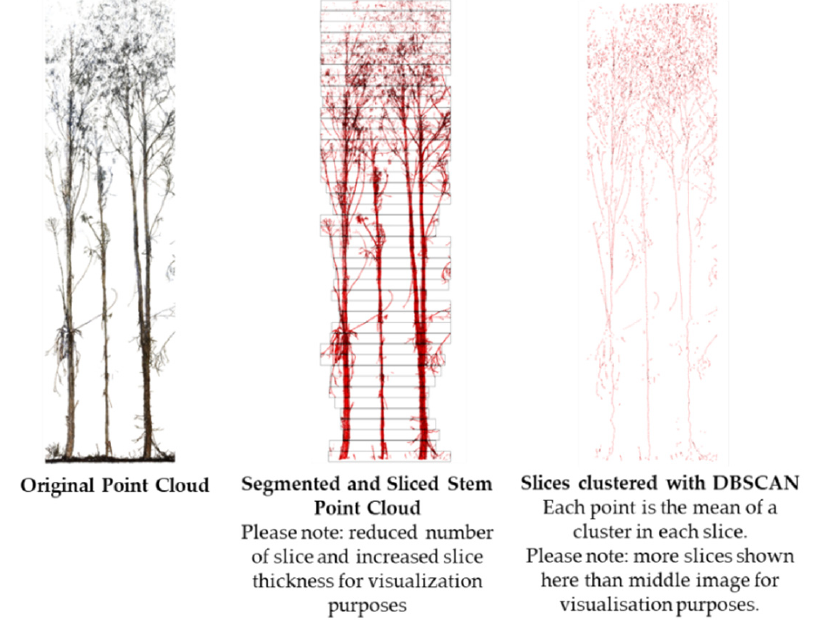
Figure 3. Left : the original point cloud input. Middle : the segmented stem-only points are sliced horizontally for clustering using HDBSCAN. The median value of each cluster in each slice becomes the skeleton shown on the right .